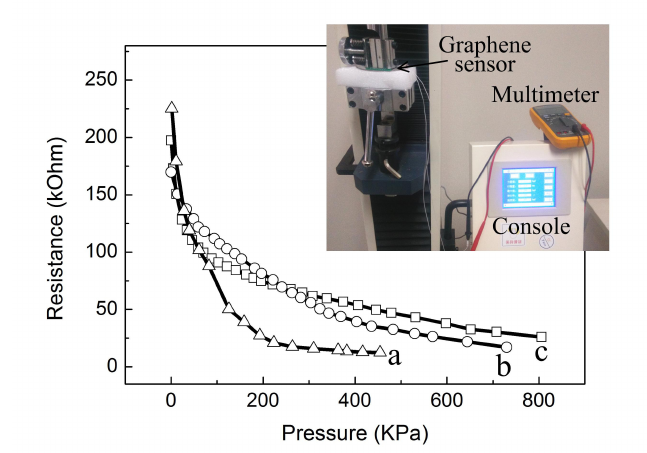
Figure 4. The resistance curves of the graphene textile pressure sensors vs. applied loading. a: 2-layers textile sensor; b: 3-layers textile sensor; c: 4-layers textile